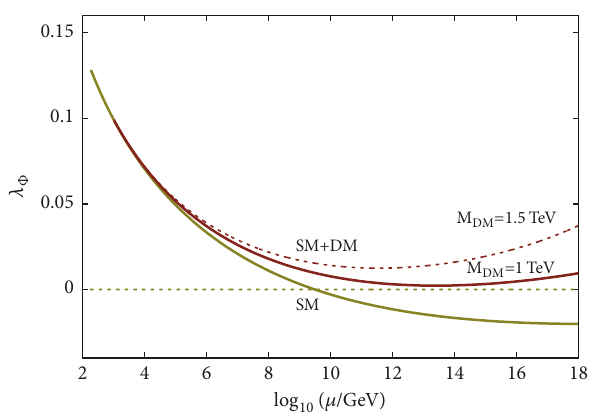
Figure 8: Running of Higgs quartic